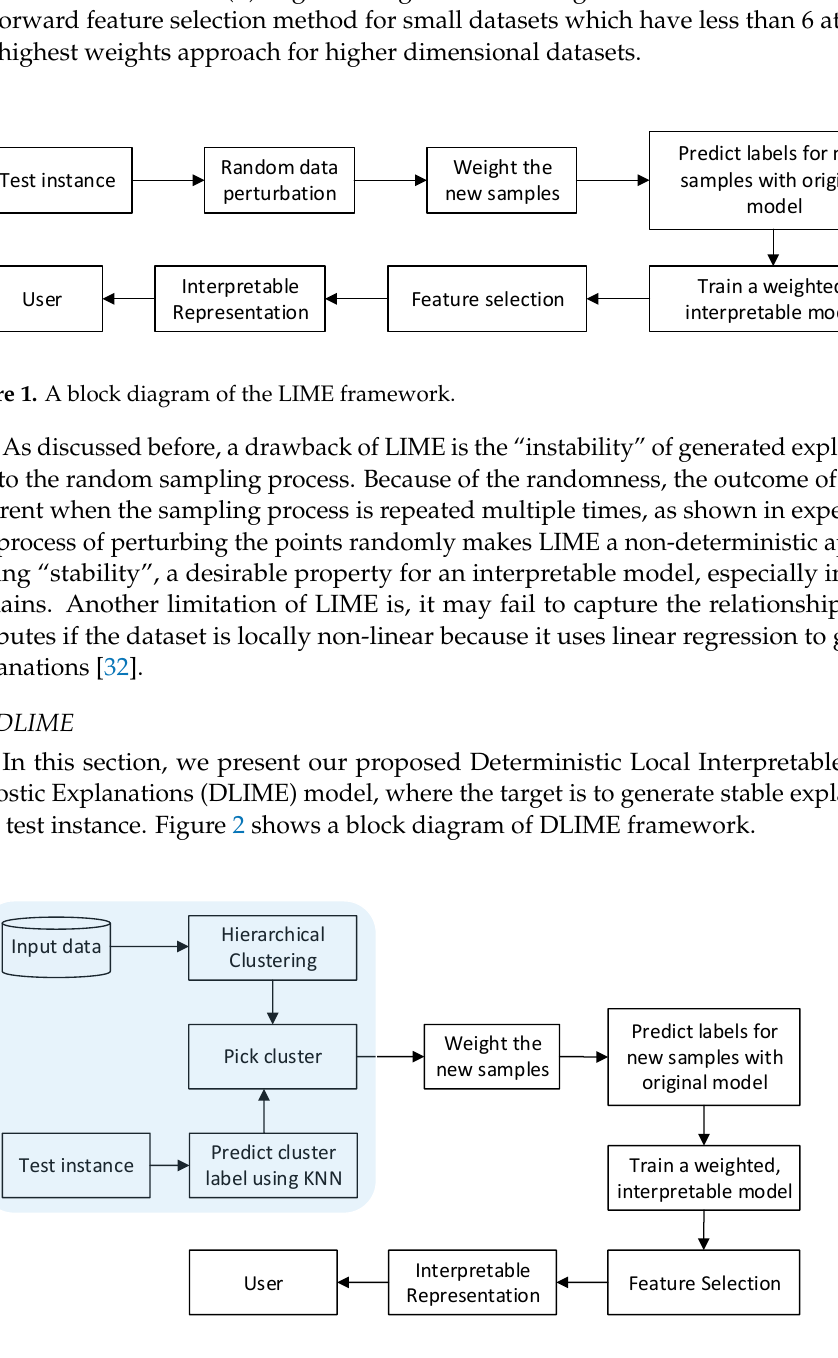
Figure 2. A high level block diagram of the DLIME